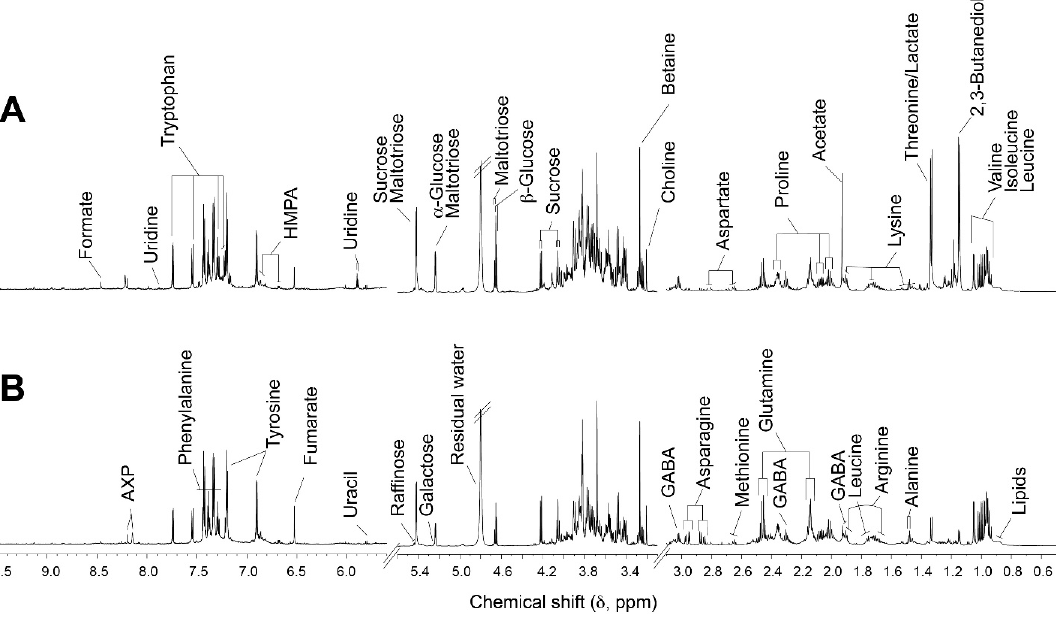
Figure 2. Representative 1 H 700 MHz nuclear magnetic resonance (NMR) spectra of wheat malt extracts of ( A ) German wheat malt (GW) and ( B ) Korean wheat malt Keumkang (KWK) cultivar. HMPA, 4-hydroxy-3-methoxyphenylacetate; AXP, adenosine mono- / di- / tri-phosphate; GABA, gamma-aminobutyrate.